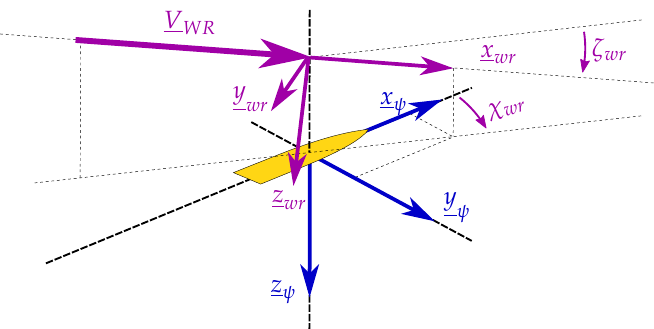
Figure 5. Drawing of the relative wind reference frame R wr . The y wr -axis and z wr -axis are the result of a double rotation of angles ( χ wr , ζ wr ) , according to the Euler convention, applied to the heading reference frame R ψ .